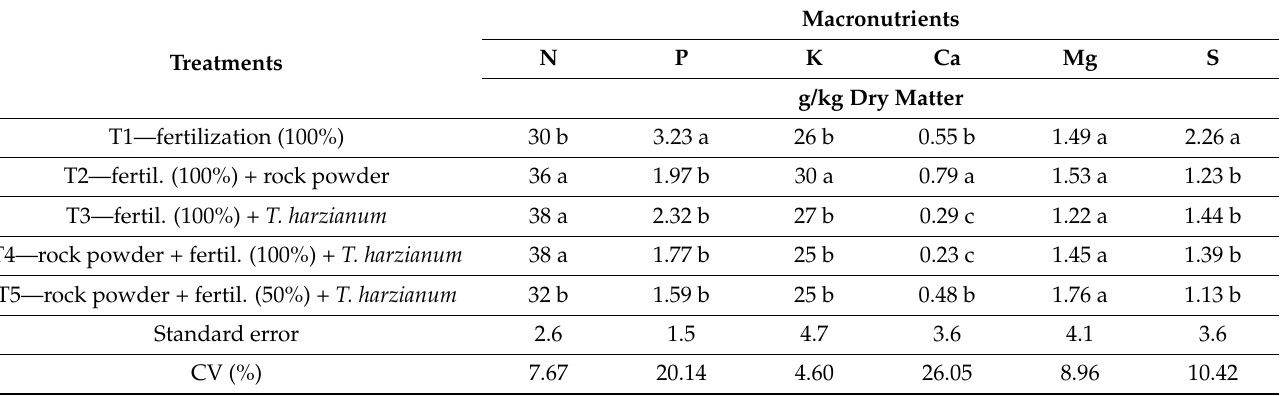
Table 2. Chemical analyses of the macronutrients nitrogen (N), phosphorus (P), potassium (K), calcium (Ca), magnesium (Mg), and sulfur (S) expressed in g/kg of dry matter, performed on maize leaves (40 DAE) with the association of Trichoderma harzianum , rock powder, and conventional fertilization (experiment